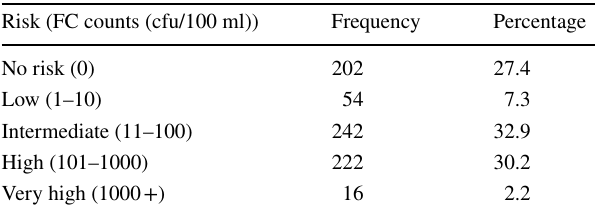
Table 4 Level of faecal contamination of household drinking water in North Gondar zone, Ethiopia, 2016 ( n =